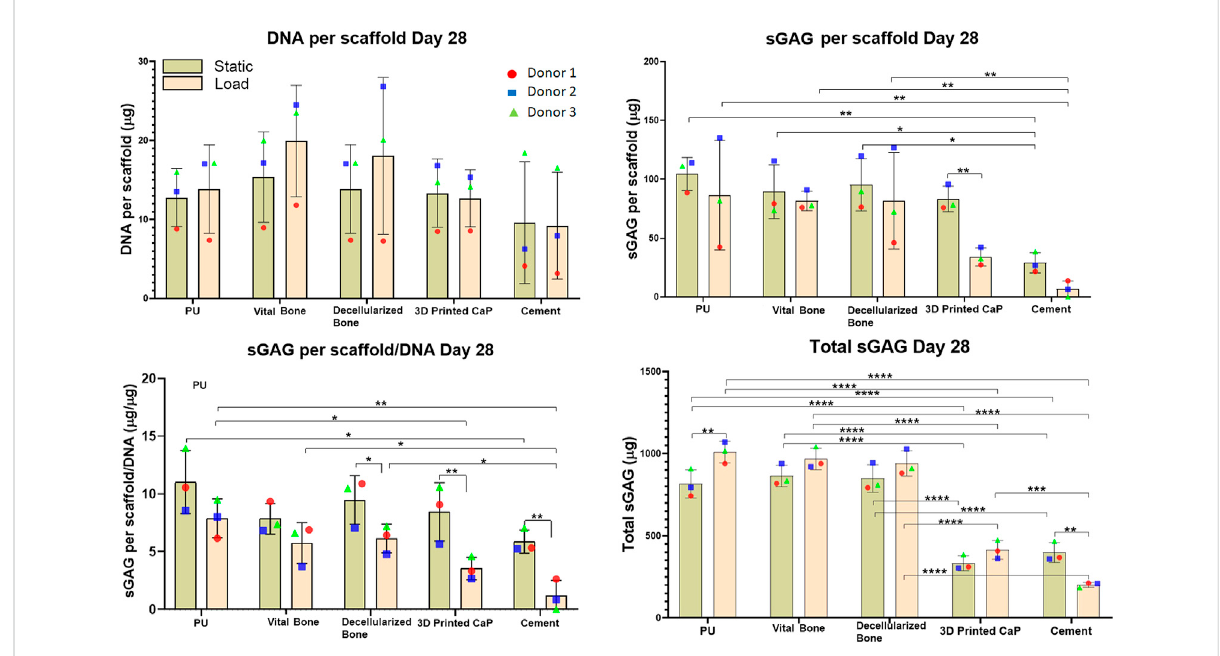
FIGURE 4 DNA, GAG per scaffold, Total GAG per scaffold/DNA, Total sGAG released into the media and total sGAG (media plus scaffold) produced over the entire 28-days. Load led to reduced sGAG per scaffold/DNA, mainly due to the load leading to an increased release of GAG into the